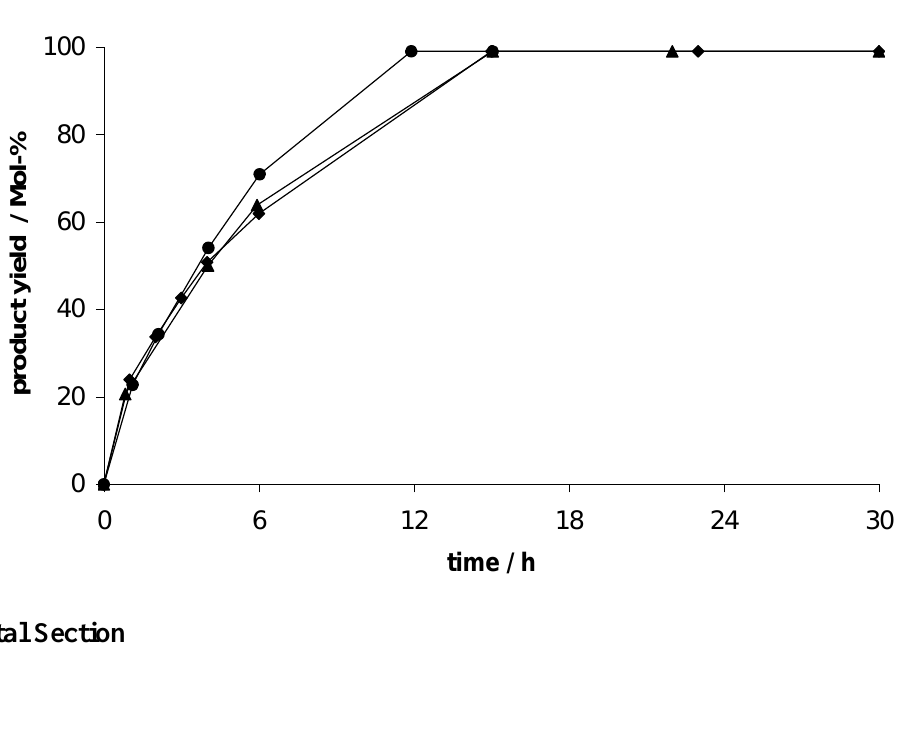
Figure 10. Product concentration during the EOF-5 catalyzed cyanosilylation of benzaldehyde, three consecutive runs were monitored: 1st run (circles), 2nd run (triangles), 3rd run